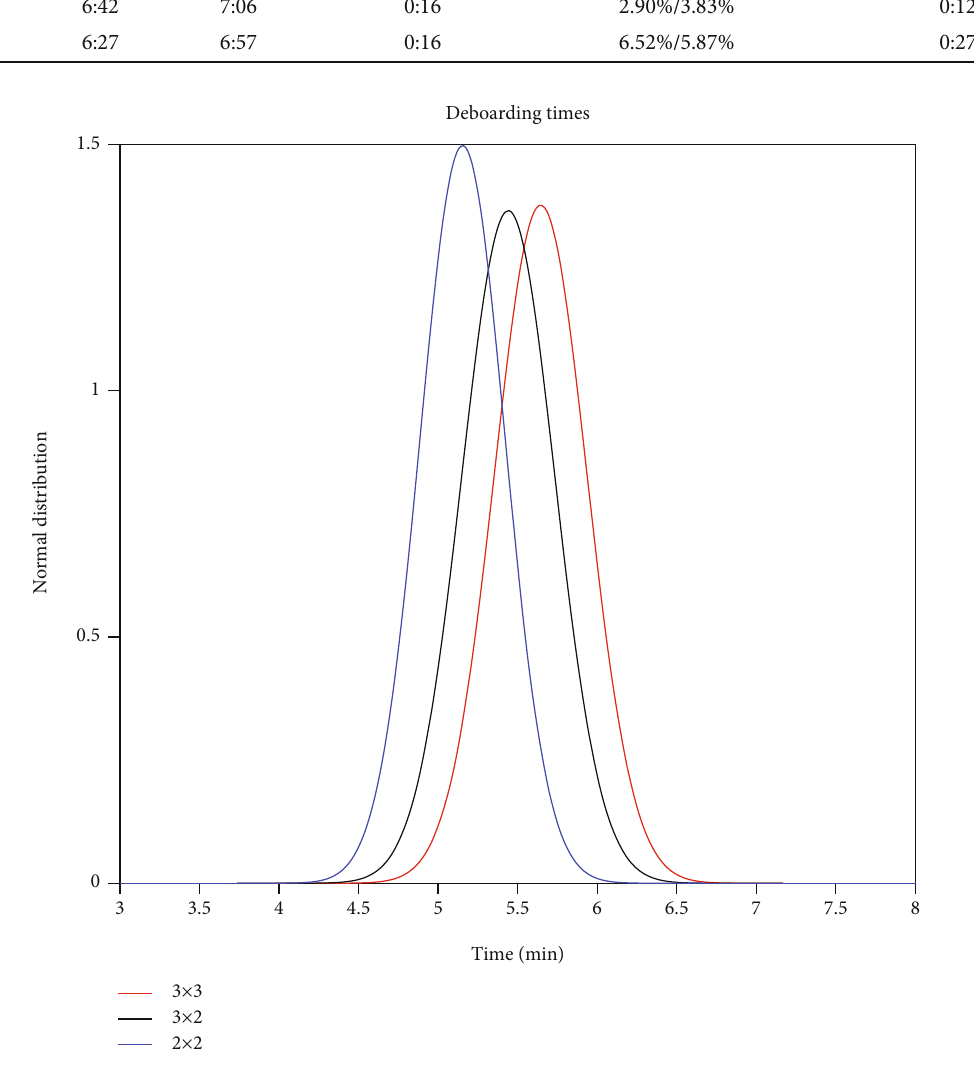
Figure 4: Fitted normal distribution curves for deboarding for the three aircraft con fi gurations: 3 × 3 , 3 × 2 , and 2 × 2